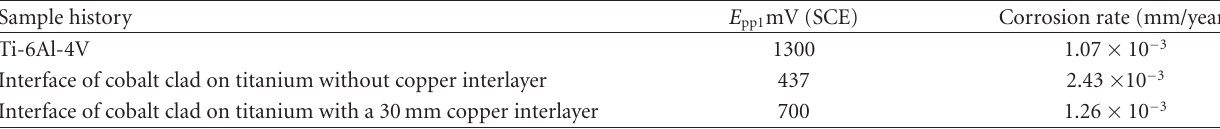
Table 2: Corrosion behavior of the dissimilar interface in a 3.56 wt.% NaCl solution.